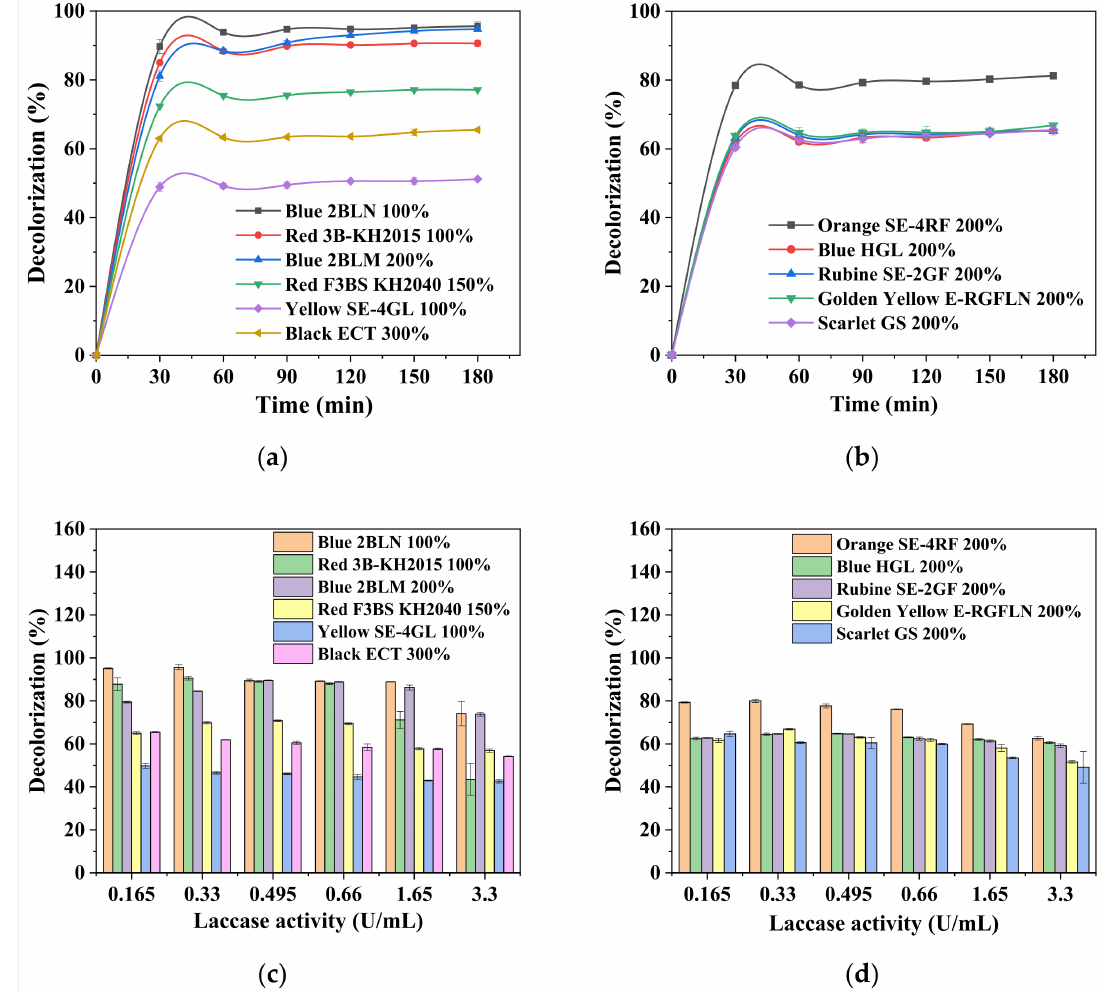
Figure 2. Time course of decolorization rate of 11 disperse dyes ( a , b ) under optimal reaction condi- tions listed in Table 1. Effect of laccase loading (0.165–3.3 U/mL) on decolorization of 11 disperse dyes with other parameters at optimal conditions ( c , d